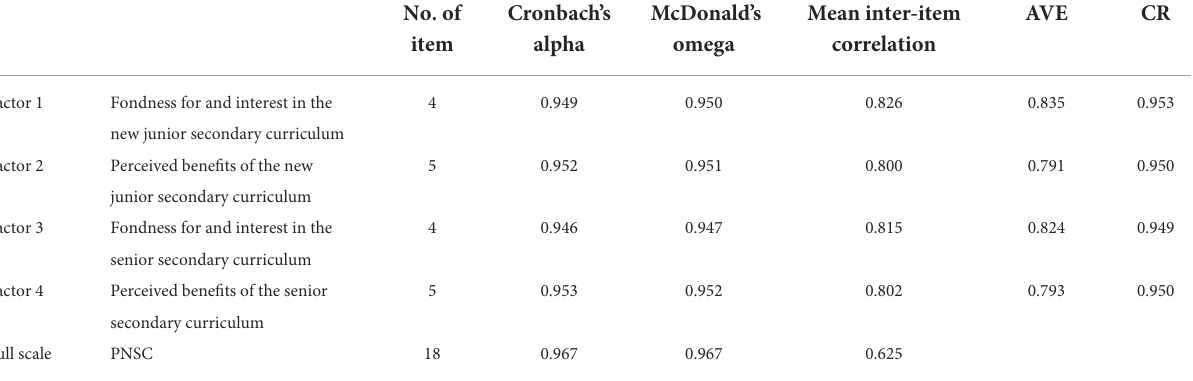
TABLE 2 Reliability and validity of full scale and factors of